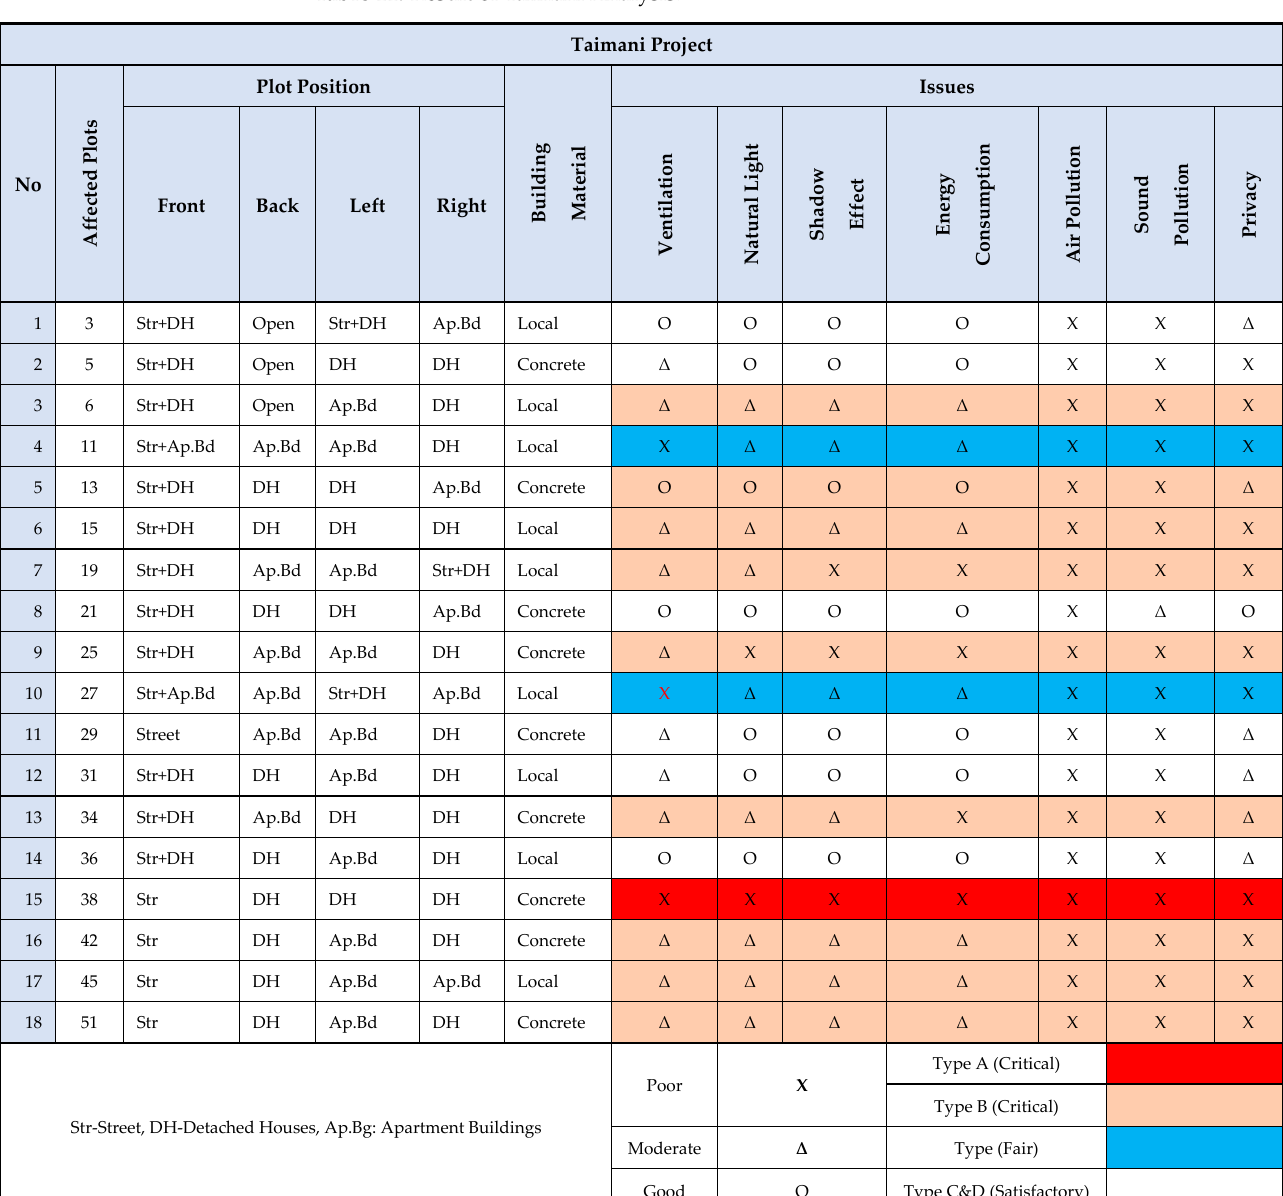
Table 11. Result of Taimani Analysis.